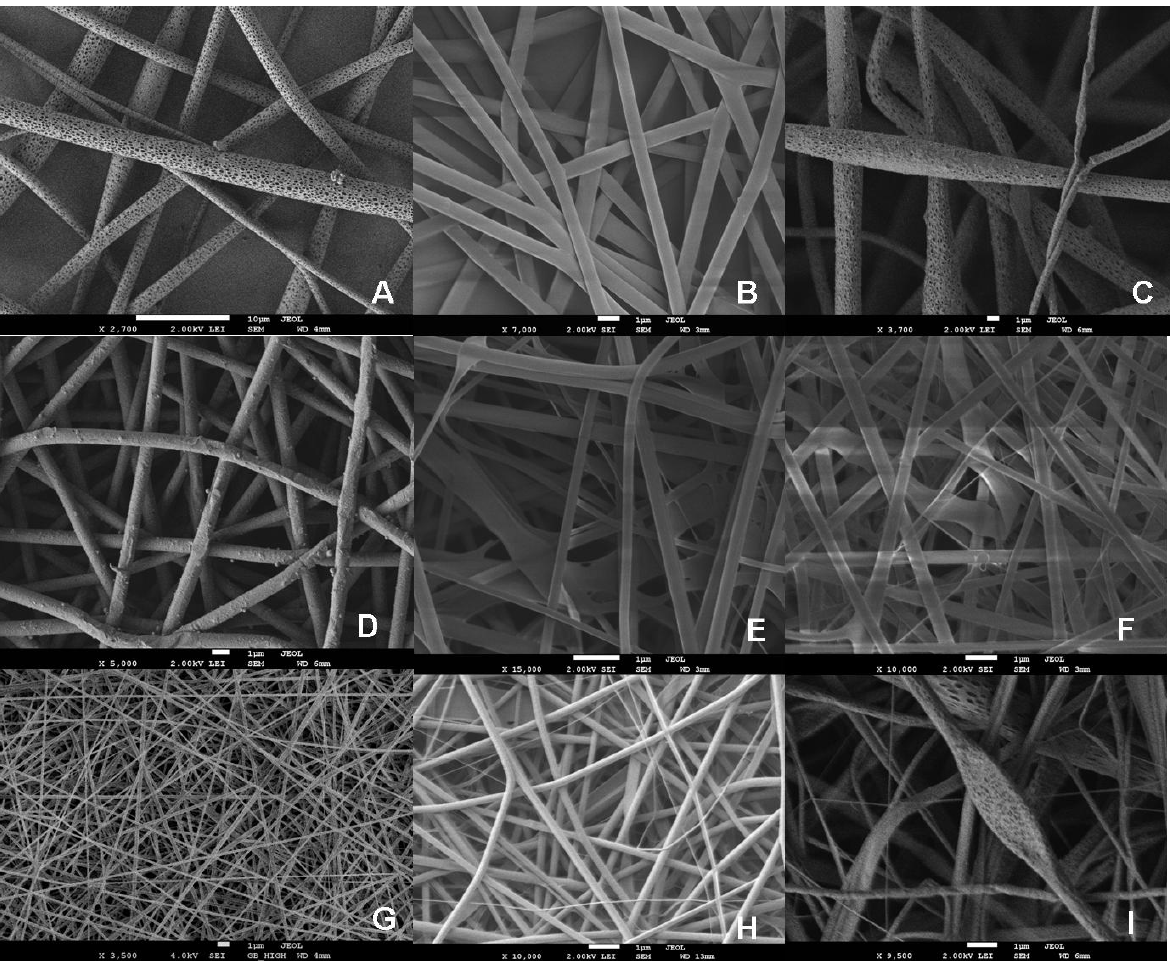
FIGURE 1. SEM analysis of PLLA nanofibers after different functionalization procedures. PLLA electrospun from DCM (A) or HFIP (B). PLLA electrospun from DCM (C) or HFIP (D) after incubation in the presence of cells over a period of 22 days. PLLA-COLI blend 1:1 ratio (E) and PLLA-COLI blend 4:1 ratio (F). Same blend supplemented with BMP-2 (G). PLLA electrospun from HFIP supplemented with BMP-2 (H) and PLLA electrospun from DCM supplemented with BMP